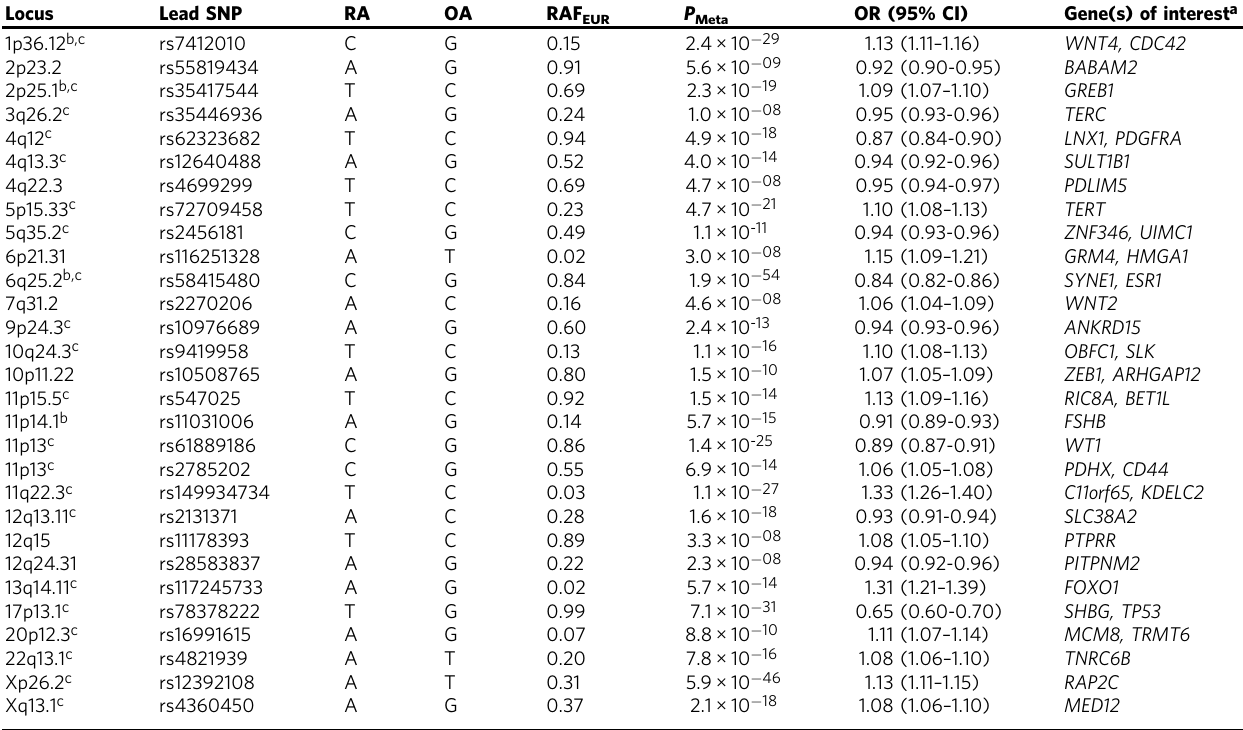
Table 1 Overview of lead SNPs with signi fi cant associations at 29 independent loci in UL GWAS meta-analysis Locus